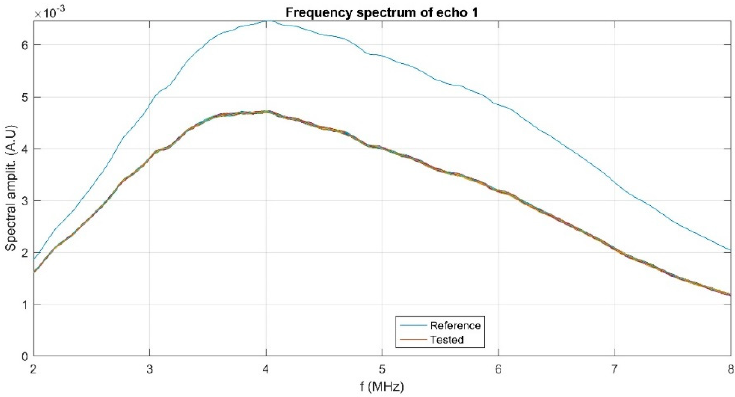
Figure 4. Frequency spectrum of echo 1 for all records and for the reference fluid (blue line).